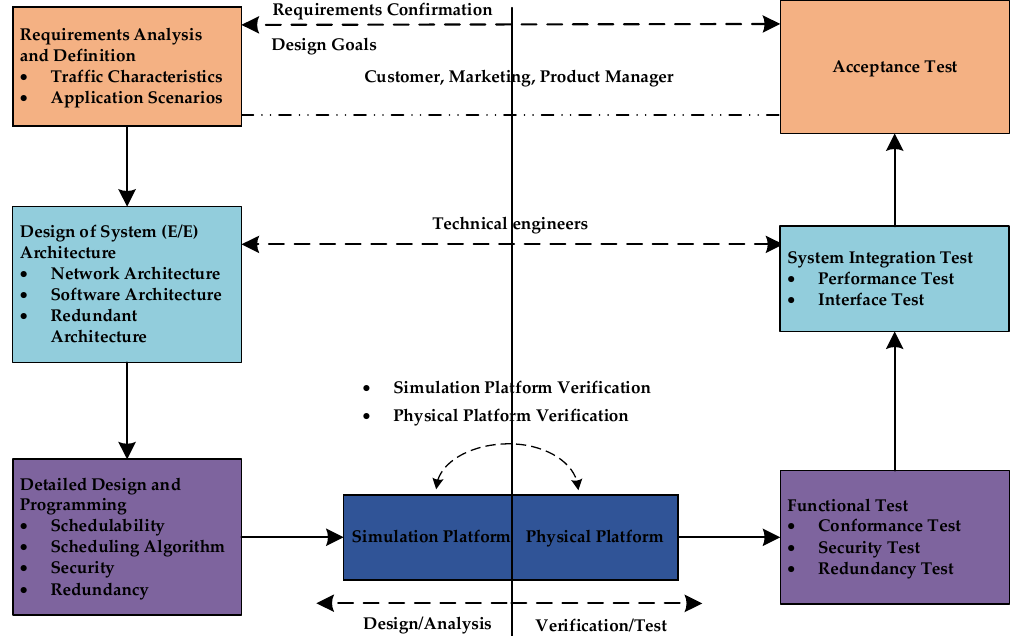
Figure 1. The methodology for the design of automotive TSN networks.